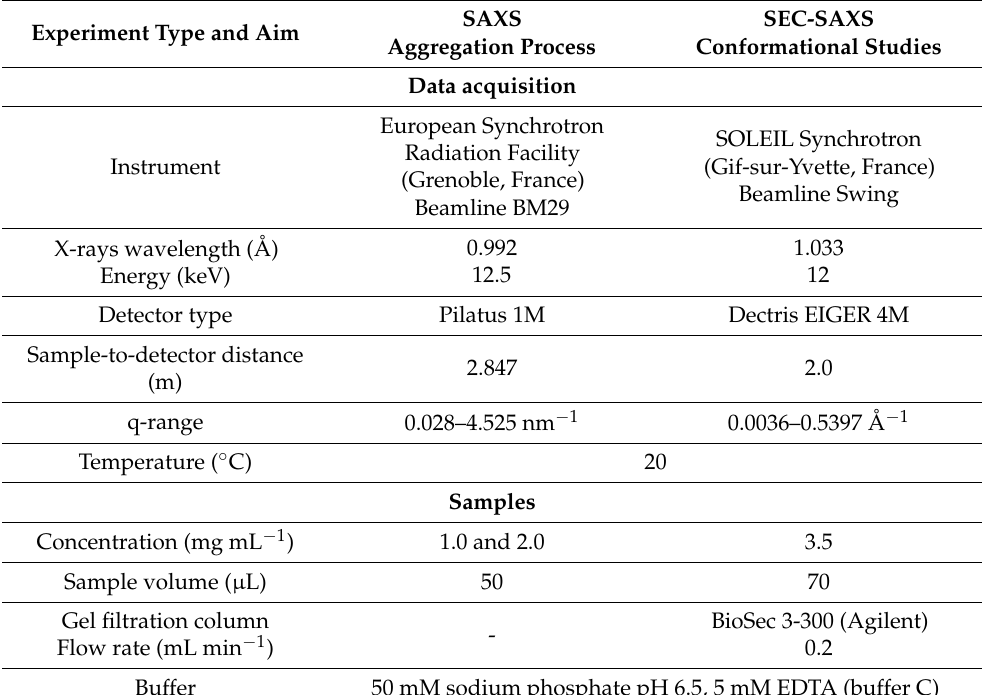
Table 1. SAXS and SEC-SAXS data acquisition